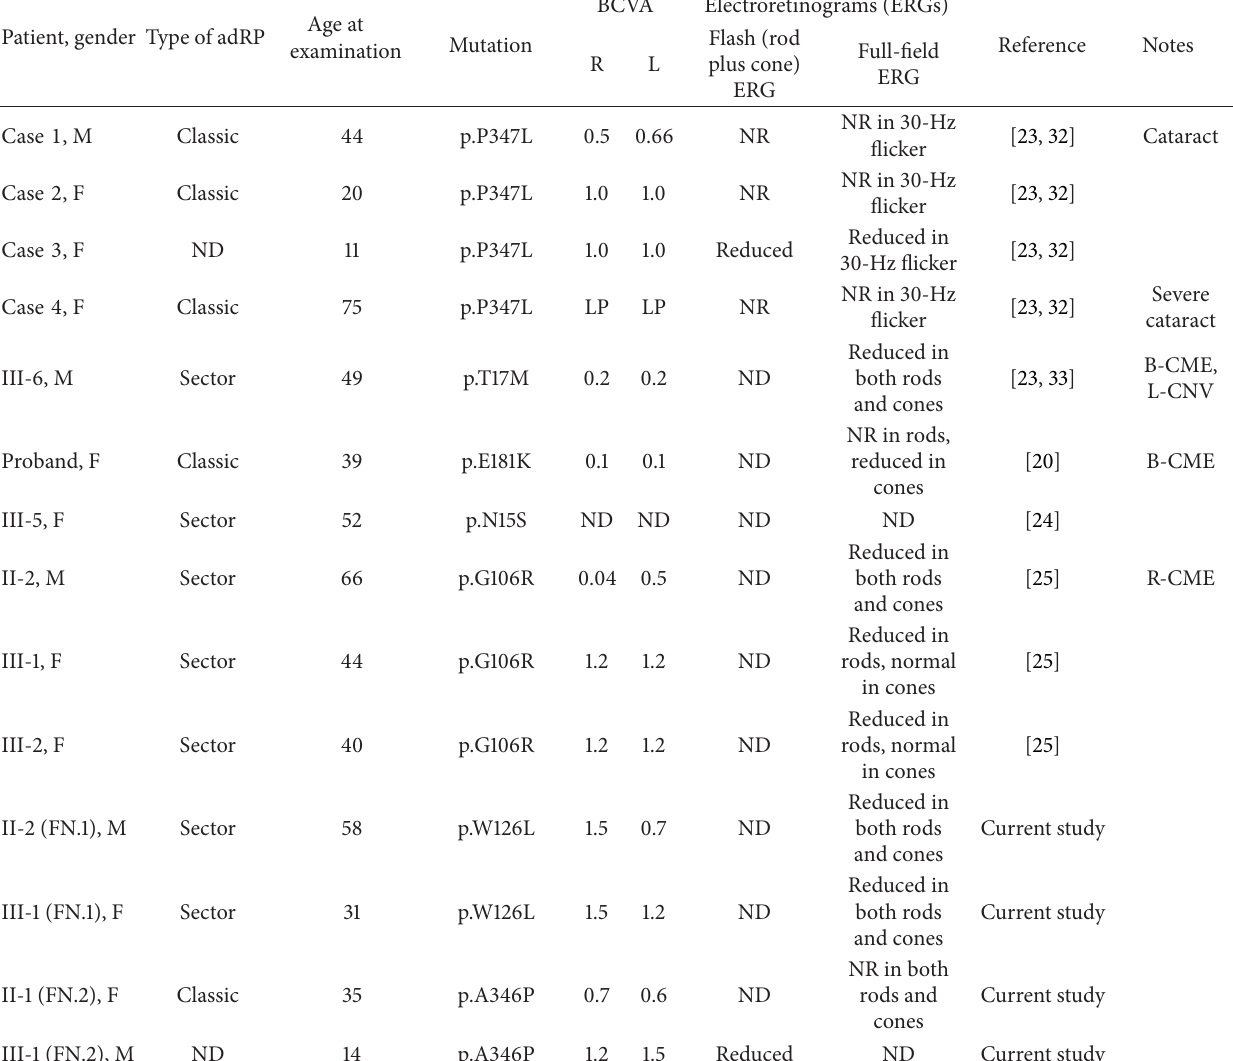
Table 2: Clinical summary of Japanese patients with autosomal dominant retinitis pigmentosa with heterozygous RHO mutations.